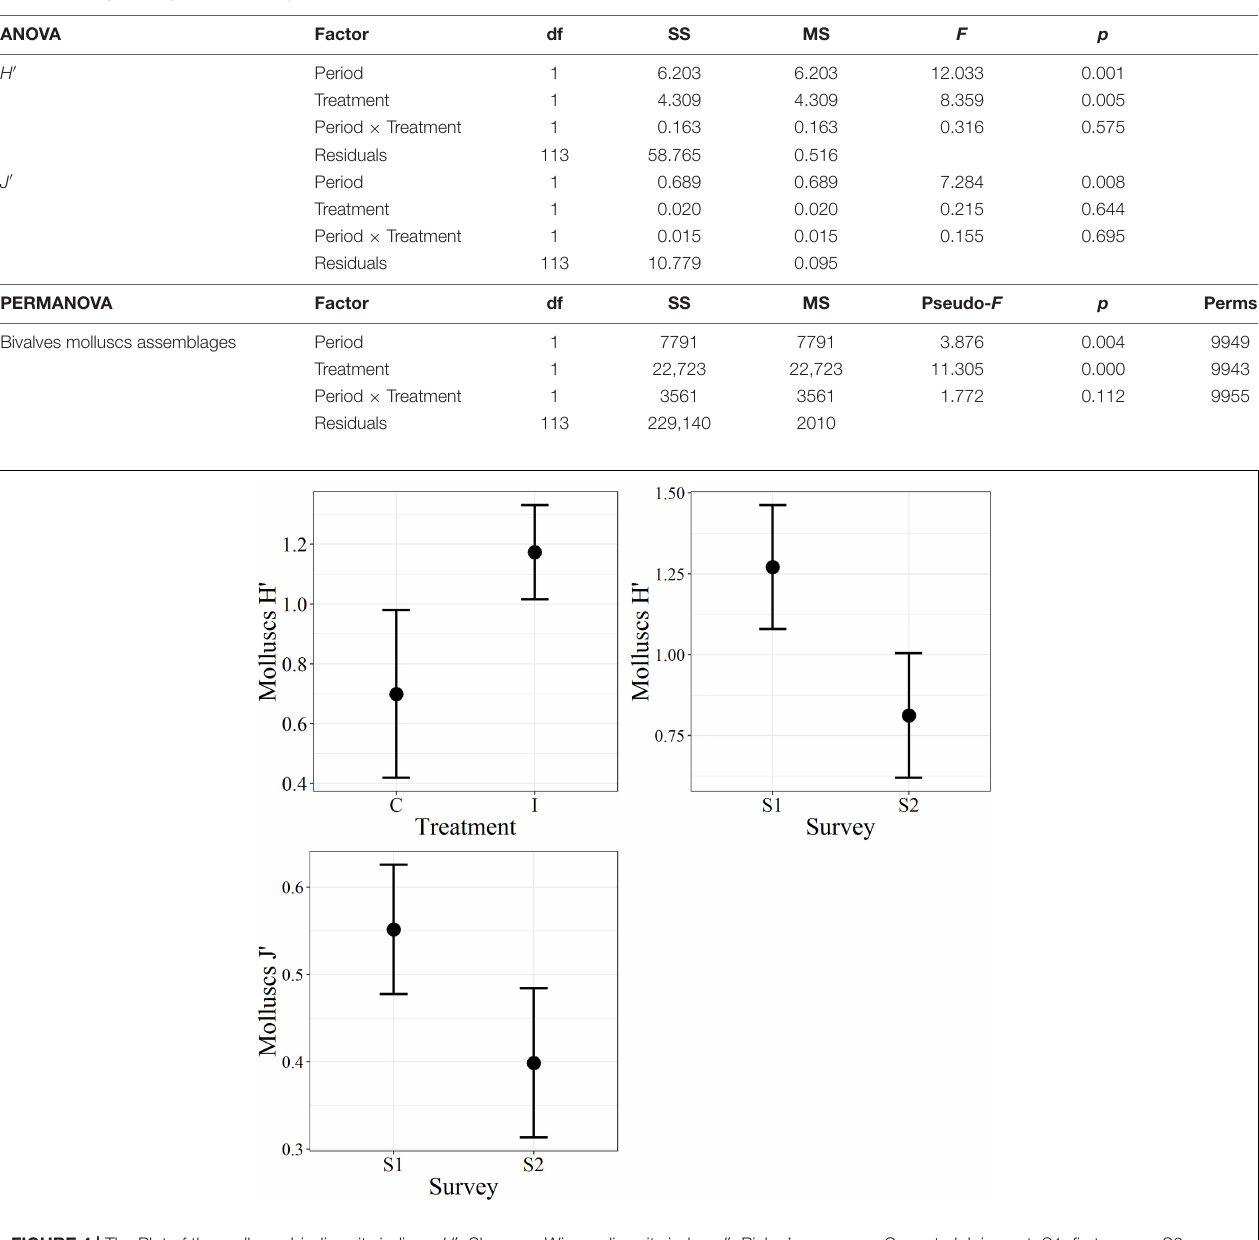
two species Acanthocardia tubercolata and Sipunculus nudus were almost borderline in discriminating between the two